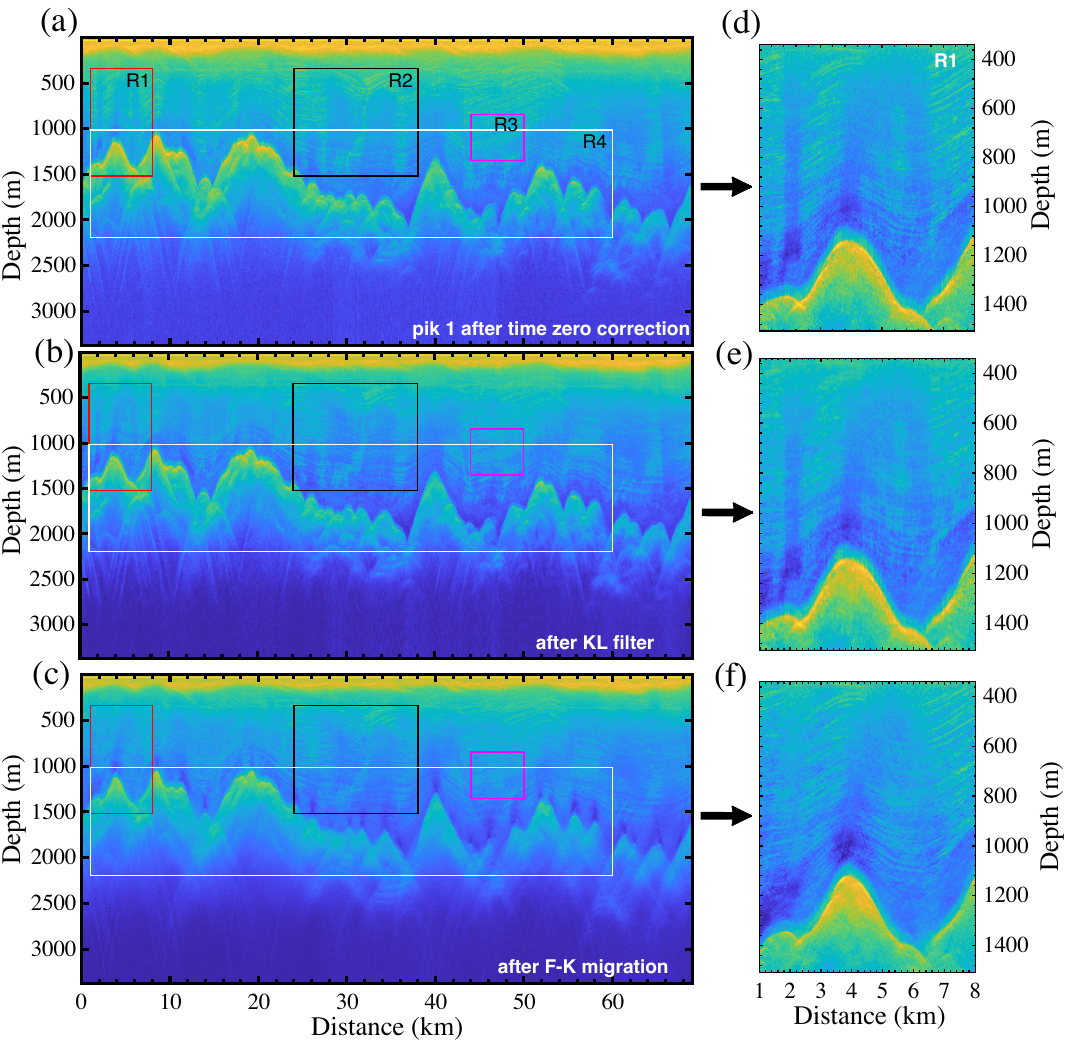
Figure 2. Radar data and processing results of Line 1 (TSH data). ( a – c ) are the results of time zero correction (two-dimensional interpolation and removal of the air layer signal), KL filtering, and F–K migration in the processing sequence. The rectangular boxes in the profile are the four areas selected for quantitative evaluation index calculation (R1—red; R2—black; R3—magenta; and R4—white). ( d – f ) are the corresponding R1 areas in ( a – c ),